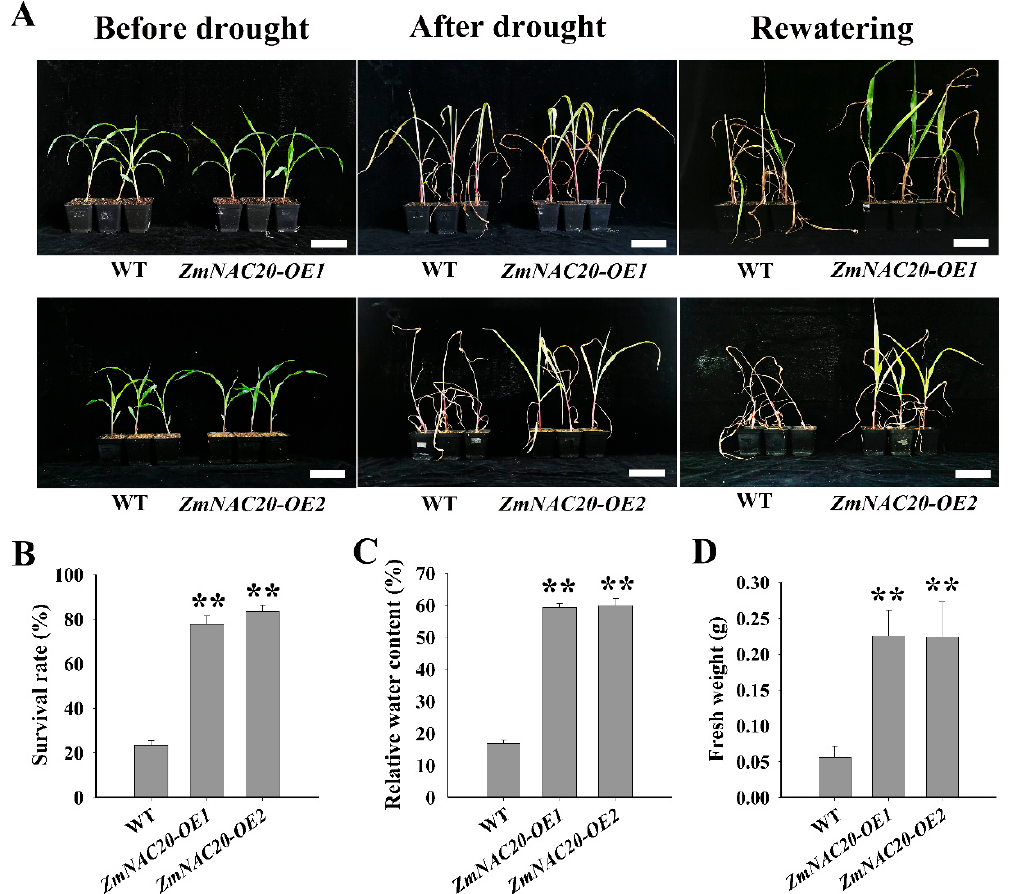
Figure 2. Phenotype of ZmNAC20 -overexpressing transgenic maize. ( A ) Drought resistance of transgenic maize overexpressing ZmNAC20 . Images were taken before and after drought stress treatment and rewatering. WT represented the wild-type B104 maize and served as the control. ZmNAC20-OE1 and ZmNAC20-OE2 represented the two ZmNAC20 -overexpressing maize lines. Bars, 5 cm. ( B ) Statistical data for the survival rate of WT, ZmNAC20-OE1 , and ZmNAC20-OE2 . The survival rate was obtained from 30 seedings in three independent tests. ( C ) The relative water content of maize leaves under drought stress treatment. The second leaves were cut from drought-treated plants. SE values were calculated from three biological replicates and more than 10 plants were examined in each replicate. ( D ) Fresh weight of maize leaves under drought stress treatment. SD values were calculated from three biological replicates and more than 10 plants were examined in each replicate. Asterisks indicate significant differences: ** p < 0.01 (Student’s t